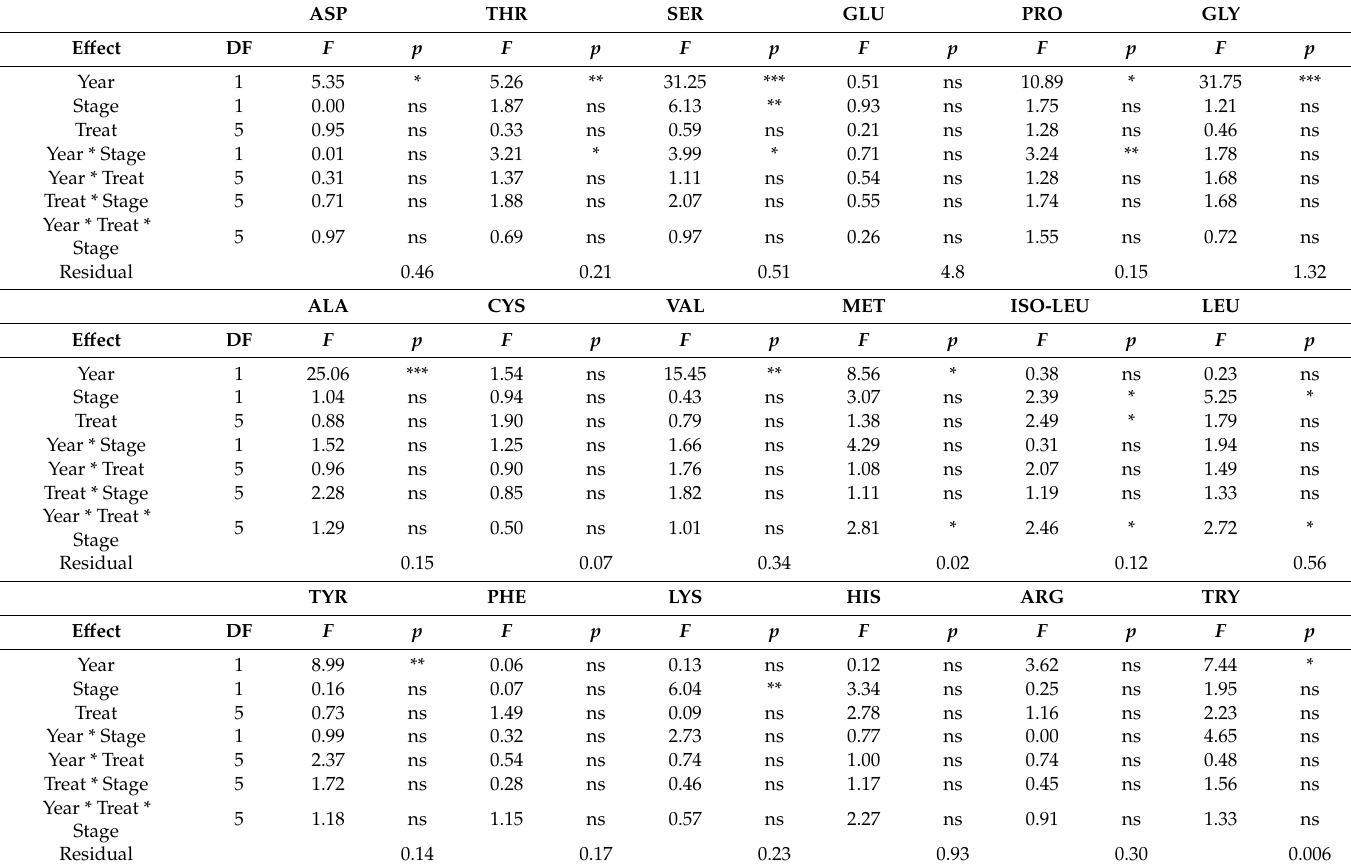
Table 2. Analysis of variance ( F and p values a ) for the e ff ects of harvest aids (treatments, Treat: paraquat, paraquat + carfentrazone-ethyl, carfentrazone-ethyl, NaClO 3 , glyphosate) on seed amino acids asparagine (ASP), threonine (THR), serine (SER), glutamine (GLU), proline (PRO), glycine (GLY), alanine (ALA), cysteine (CYS), valine (VAL), methionine (MET), iso-leucine (ISO-LEU), leucine (LEU), tyrosine (TYR), phenylalanine (PHE), lysine (LYS), histidine (HIS), arginine (ARG), and tryptophan (TRY) (mg g − 1 ). Untreated plants were used as the control. Harvest aids were applied at growth stages (Stage) R6 and R7. The experiment was conducted in 2012 and 2013 in Stoneville,